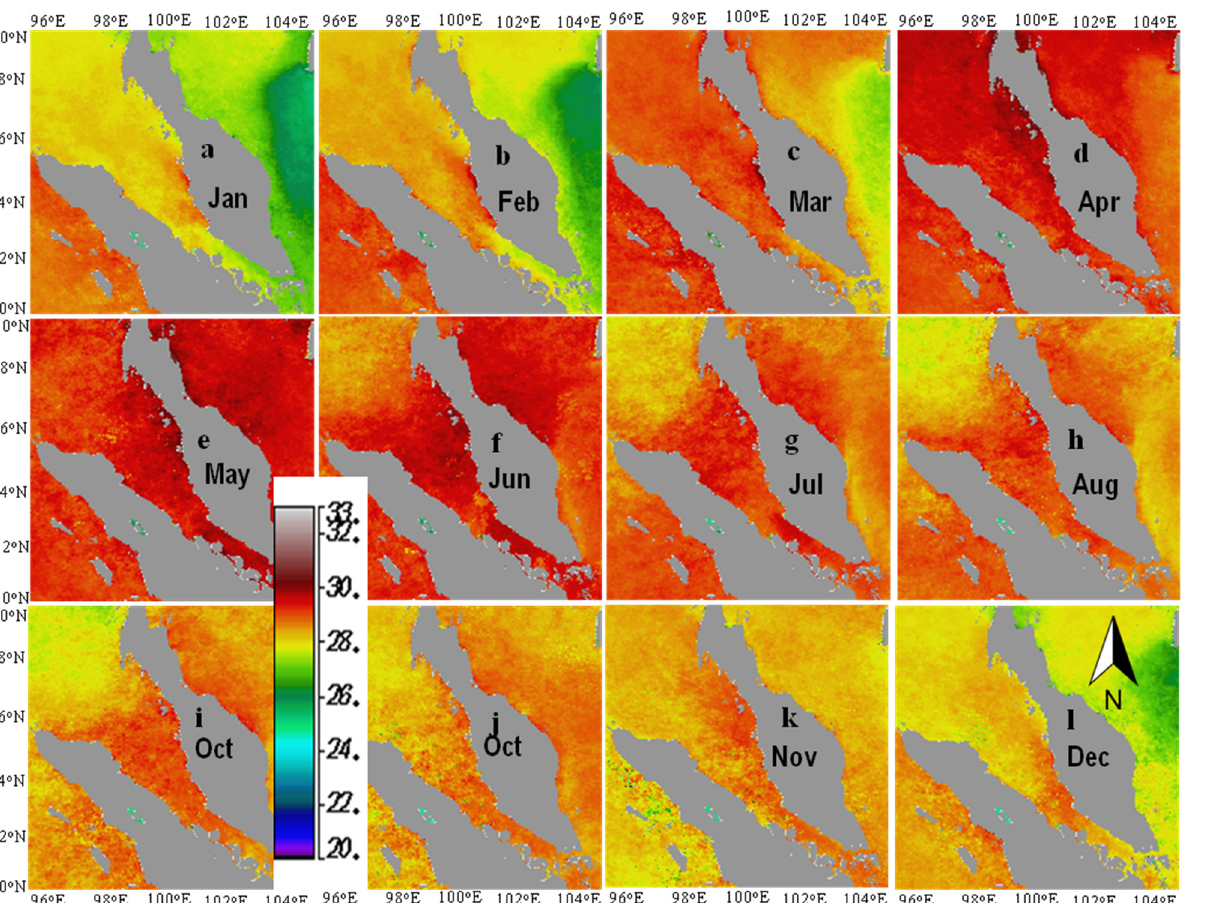
Figure 9. ( a – l ) Monthly climatological means of sea surface temperature (SST, °C) averaged from monthly AVHRR/MODIS SSTs retrieved within the period of the SeaWiFS full